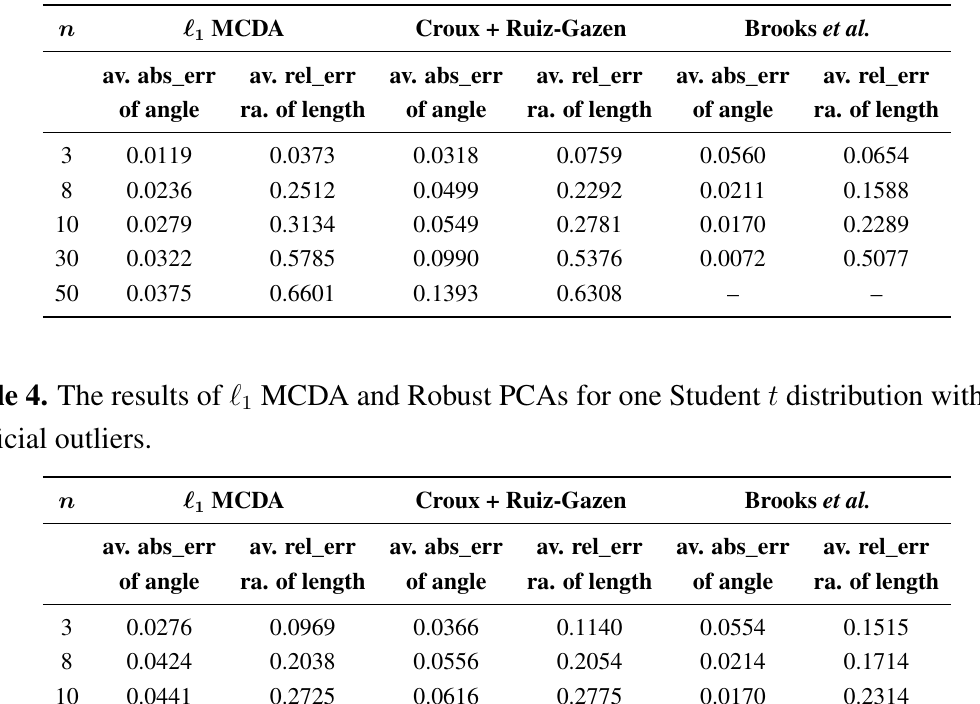
Table 3. The results of (cid:96) MCDA and Robust PCAs for one Gaussian distribution with 10% 1 artificial outliers.